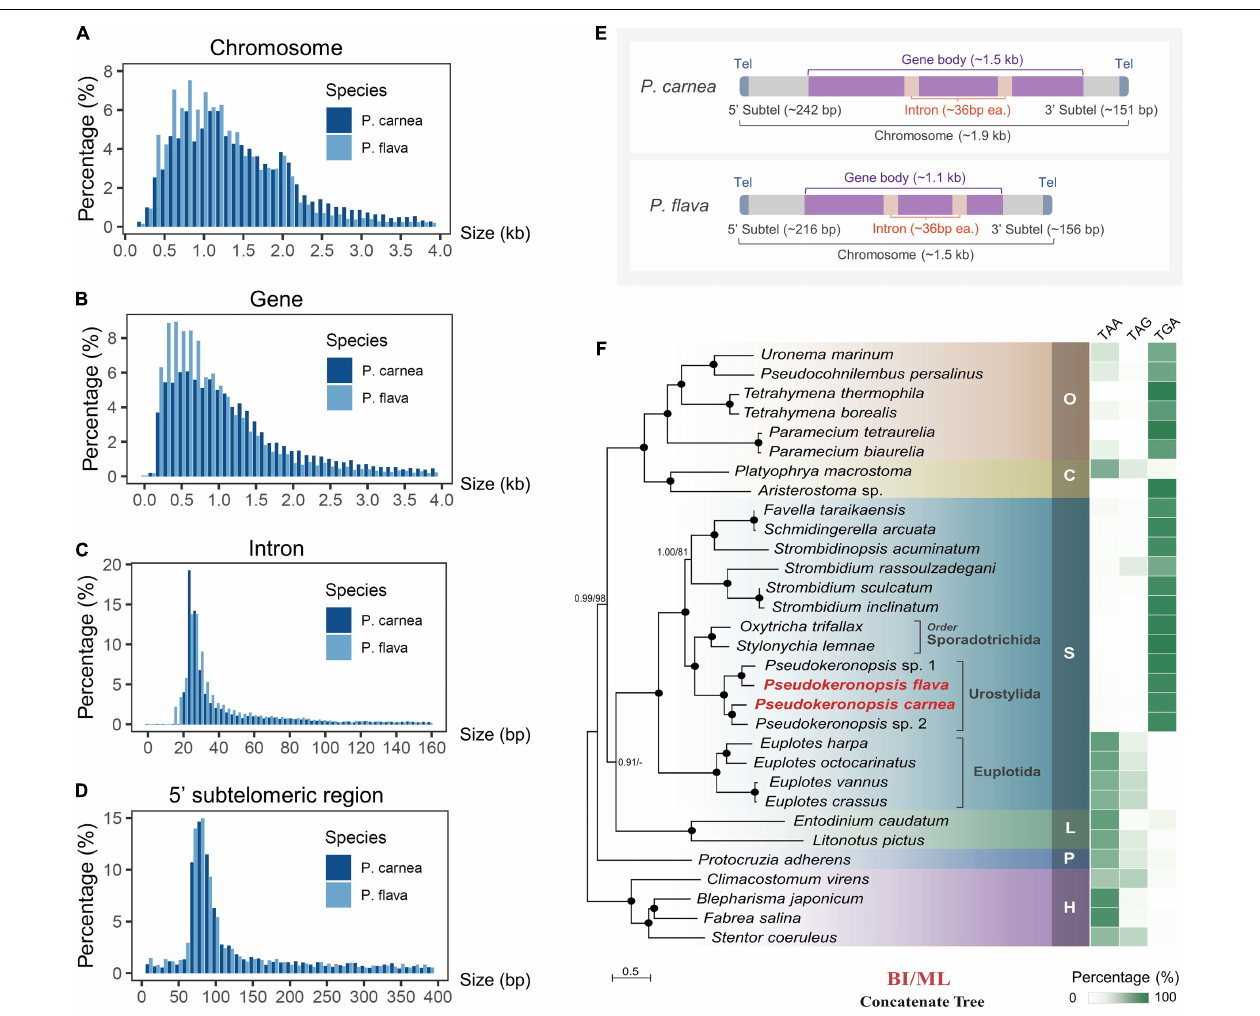
FIGURE 2 | Macronucleus (MAC) genomic features of two Pseudokeronopsis ciliates and phylogenomic analysis. (A–D) Size distribution of chromosomes, gene bodies (start to stop codon, including introns), introns, and 5 (cid:48) subtelomeric regions of P. flava and P. carnea MAC genomes. (E) A schematic illustrating the canonical structure of nanochromosomes in P. flava and P. carnea MAC genomes. Tel, telomere; Subtel, subtelomeric region. The average size of each region is shown in the parentheses. (F) Phylogenomic tree (left) and stop codon reassignment (right). Phylogenomic tree is estimated from a concatenated dataset of 238 orthologous proteins by Bayesian inference (BI) and maximum likelihood (ML) methods. Black dots denote full support (BI 1.0/ML 100%). Hyphens denote topological disagreement between ML and BI analyses. O, class Oligohymenophorea; C, class Colpodea; L, class Litostomatea; S, class Spirotrichea; P, class Protocruzia; H, class Heterotrichea; M, class Mesodiniea. The scale bar corresponds to 50 substitutions per 100 amino acid